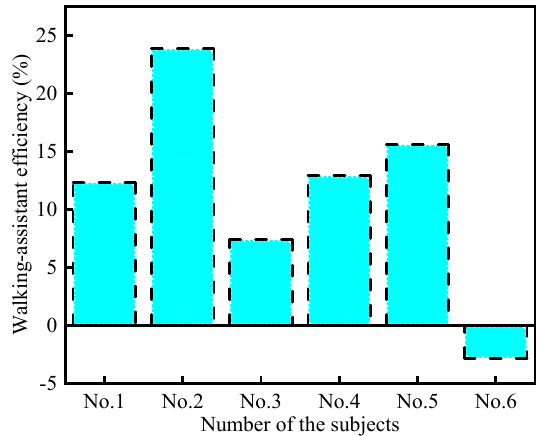
Figure 16. Walking-assistance efficiencies of the Figure 16. Walking ‐ assistance efficiencies of the exoskeleton.